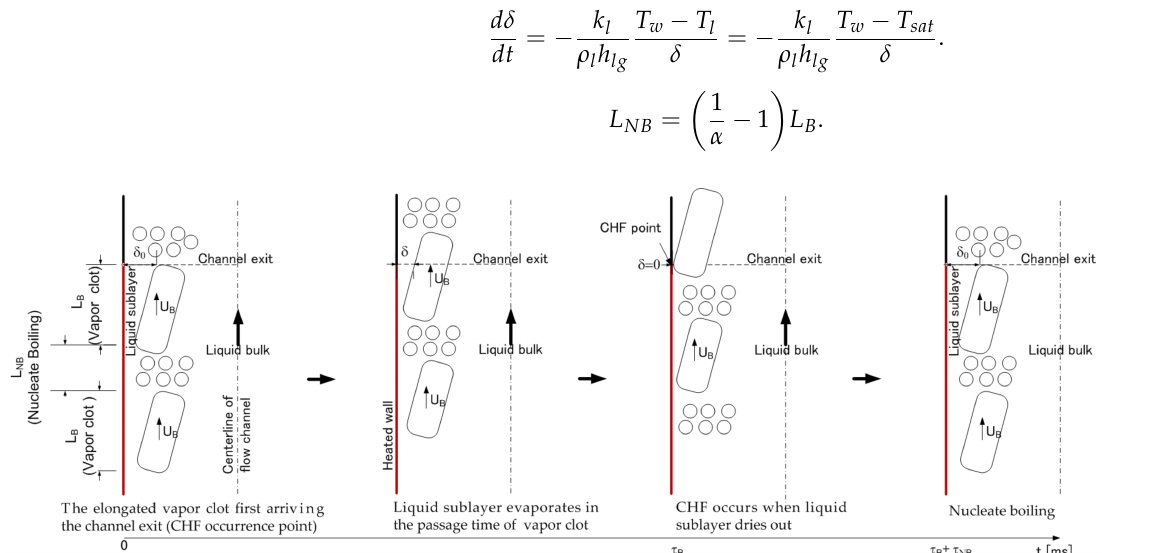
Figure 7. Near-wall vapor–liquid structure at the CHF based on liquid sublayer dryout